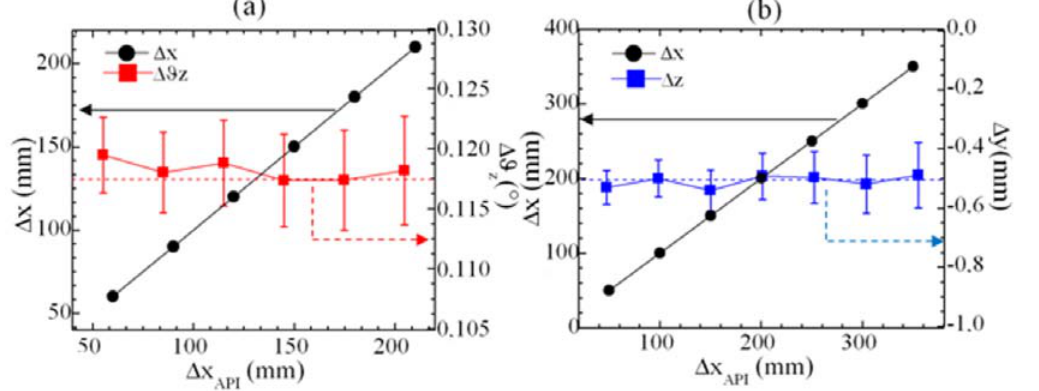
Figure 12. (a) Simultaneous measurement of a linear displacement in the range 50 – 220 mm with a fixed yaw rotation Δ  = 0.117°, pointed out by the red dotted line. z The best fit line equation related to the linear displacement is  x = 1.00000  x + API 0.00695 (R 2 = 1) (b) Simultaneous measurement of a linear displacement in the range 20 – 400 mm with a fixed straightness Δ y = - 0.5 mm, pointed out by the blue dotted line. The best fit line equation related to the linear displacement is  x = 1.00001  x - 0.00311 API (R 2 = 1). Arrows in (a) and (b) point to the relevant axis for the corresponding set of